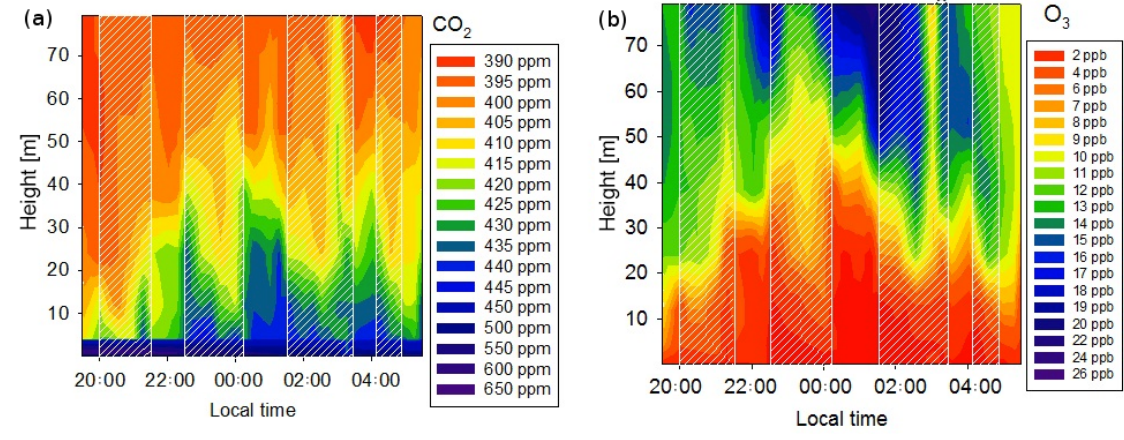
Figure 4. Same as Fig. 3 but for the intermittent night.